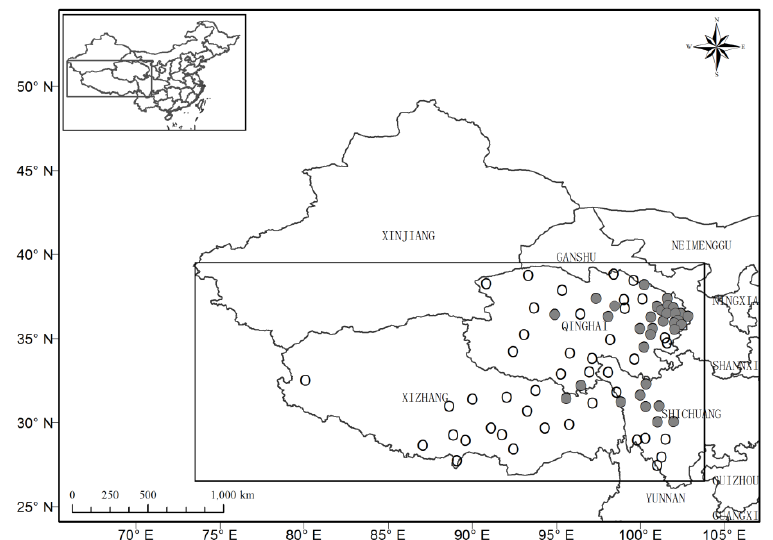
Figure 1. The distribution of weather stations (white circle) and stations in spring wheat regions (grey circles) over the Tibetan plateau (TP) area of China.